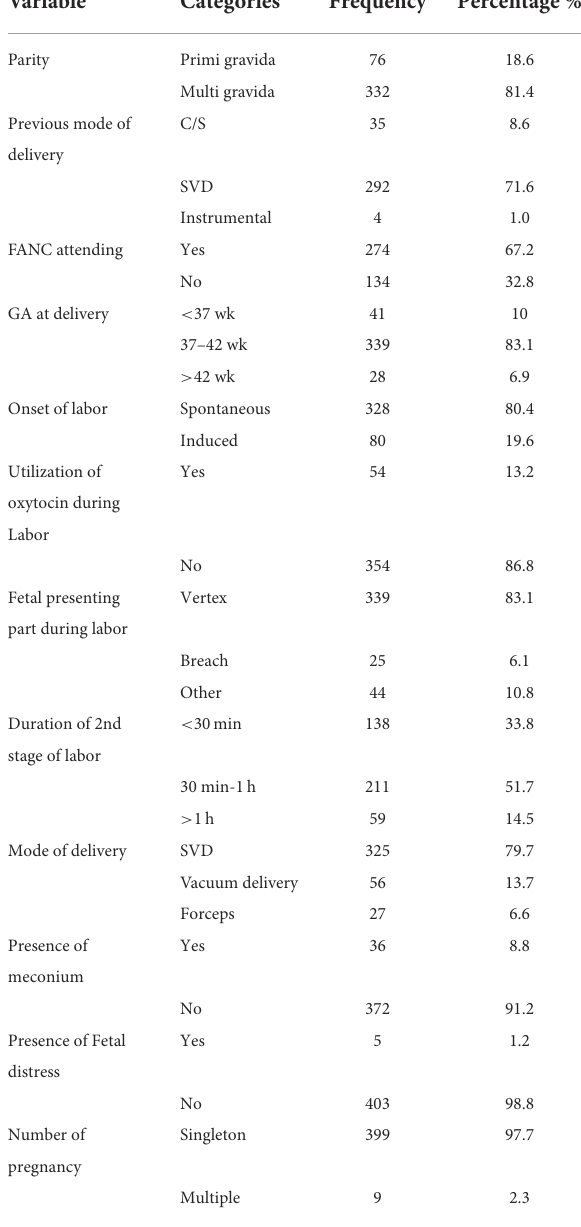
TABLE 2 Pregnancy, labor, and delivery characteristics of women who gave birth in the Hiwot Fana Specialized University Hospital, Eastern Ethiopia,